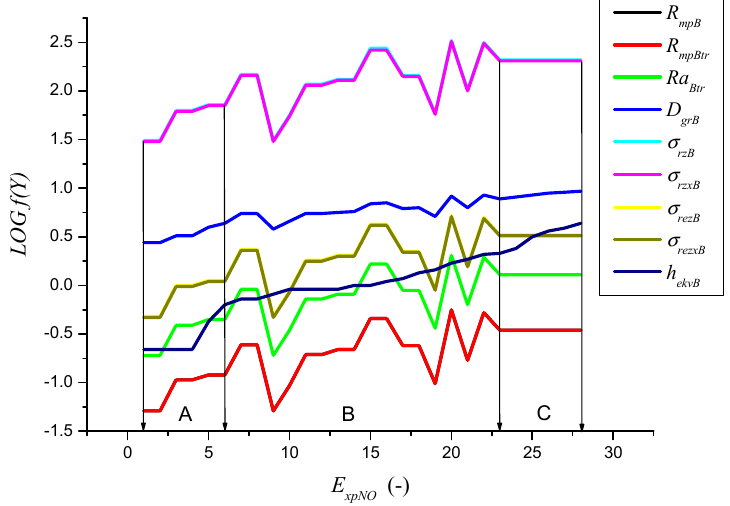
Figure 10. Comparison of working parameters LOG f ( W p ) = f ( E xpNO ) for Stellite 6, where: Section A ( E xpNO 1-6) insufficient roughness for the desired adhesion, Section B ( E xpNO 6-21) very good roughness for the desired adhesion, Section C ( E xpNO 21-24) sufficient roughness for the desired adhesion.